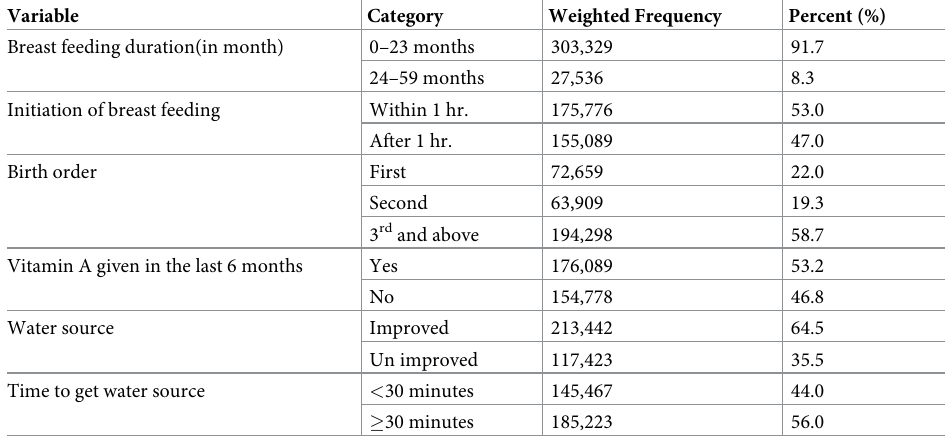
Table 3. Behavioral and environmental characteristics of respondents in sub-Saharan Africa.